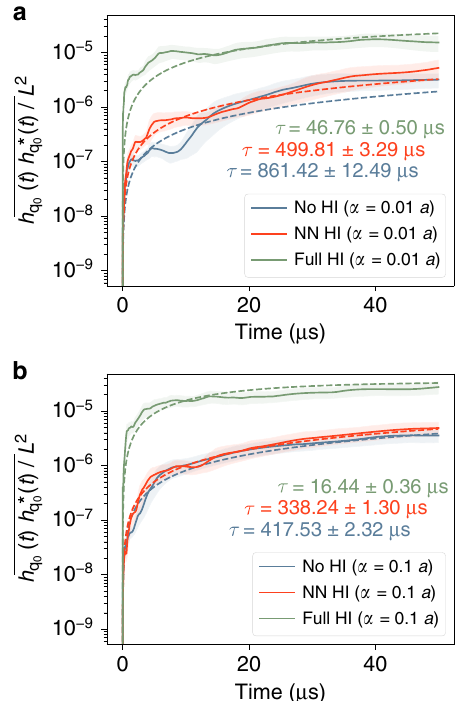
Fig. 4 Relaxation of the energy of the largest undulation mode, with the wave vector q 0 ¼ 2 π L 1 ; 0 ð Þ , for an initially fl at membrane, evolving towards equilibrium. Results are given for all the hydrodynamic cases, using two scaling factors a α = 0.01 a and b α = 0.1 a . Dashed lines are fi ts of the function kT 1 (cid:3) exp (cid:3) t = τ ð Þð Þ to the data. Corresponding values of the κ qL ð Þ 4 timescale τ for each case are colour-coded. Shaded error bands represent one standard